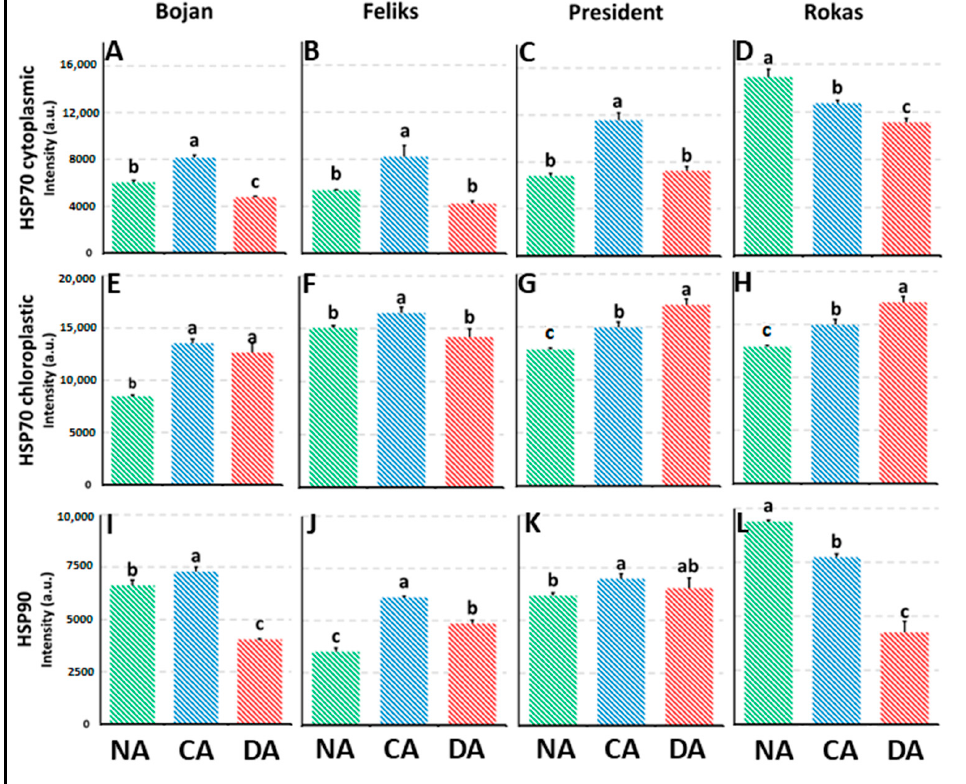
Figure 7. Changes in the accumulation of the HSP proteins in the leaves of four cultivars of the non- acclimated (NA), cold-acclimated (CA) and deacclimated (DA) oilseed rape. ( A – D )—changes in the accumulation of cytoplasmic HSP70; 3 µg of the protein was loaded onto the gel. ( E – H )—changes in the accumulation of chloroplastic HSP70; 5 µg of the protein was loaded onto the gel. ( I – L )—changes in the accumulation of HSP90; 10 µg of the protein was loaded onto the gel. Values marked with the same letters (for each cultivar separately) were not significantly different according to the Duncan test ( p ≤ 0.05).